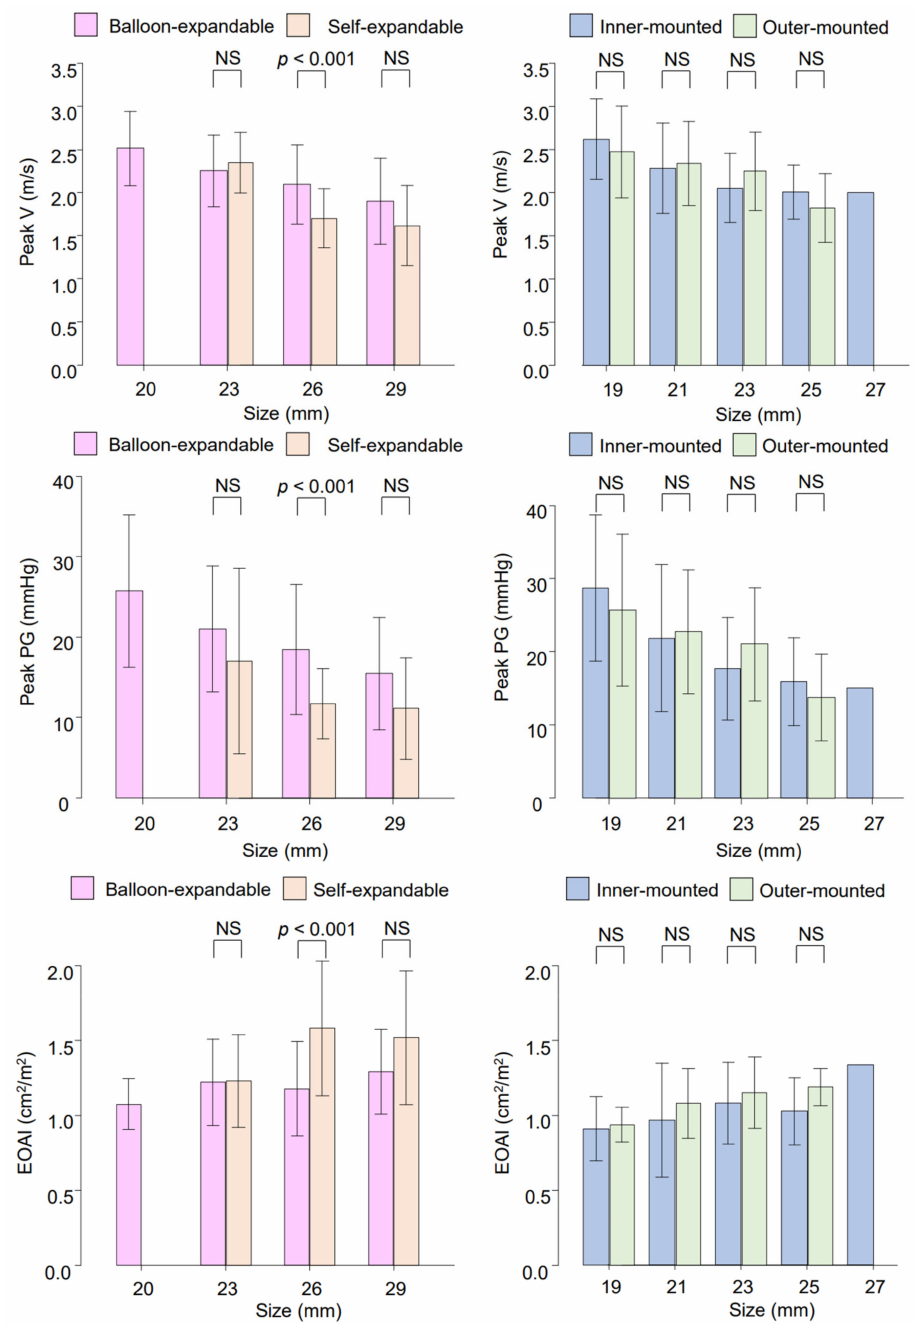
Figure 2. Valvular performances among different prosthetic types. EOAI: effective orifice area index, NS: not significant, PG: pressure gradient, V: